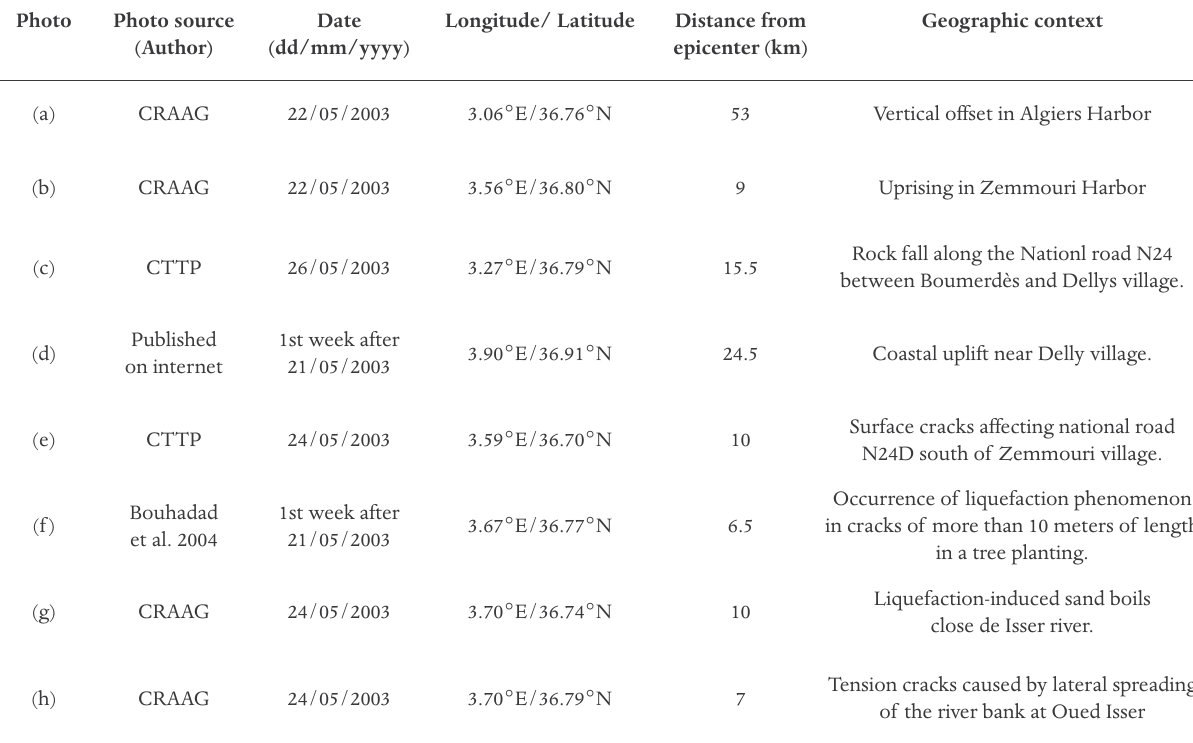
Table 3. Complementary information about photos shown in Figure 4. CRAAG: Centre de Recherche en Astronomie Astrophysique